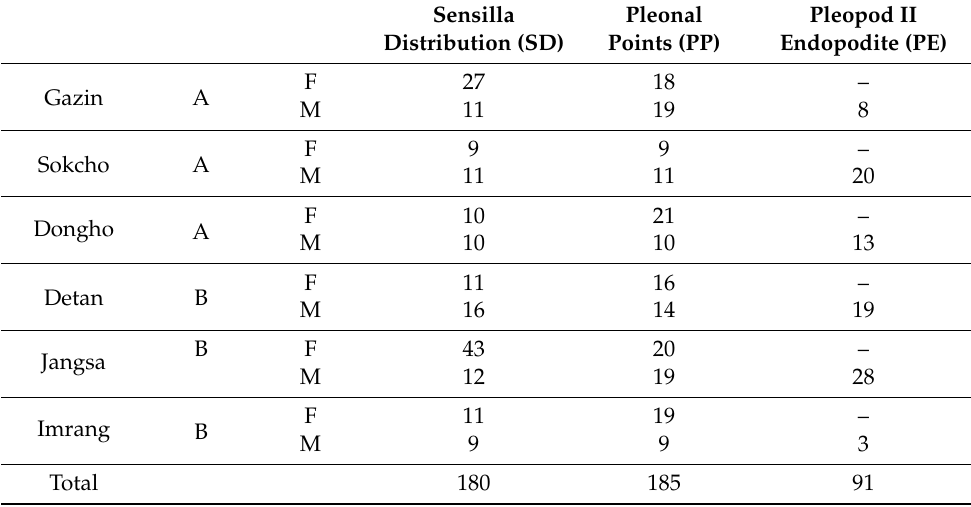
Table 1. Summary of image numbers included in the landmark-based geometric morphometrics (LBGM) analyses. The alphabets represent classifiers as ( A ) lineage A; ( B ) lineage B; ( F ) female; ( M )